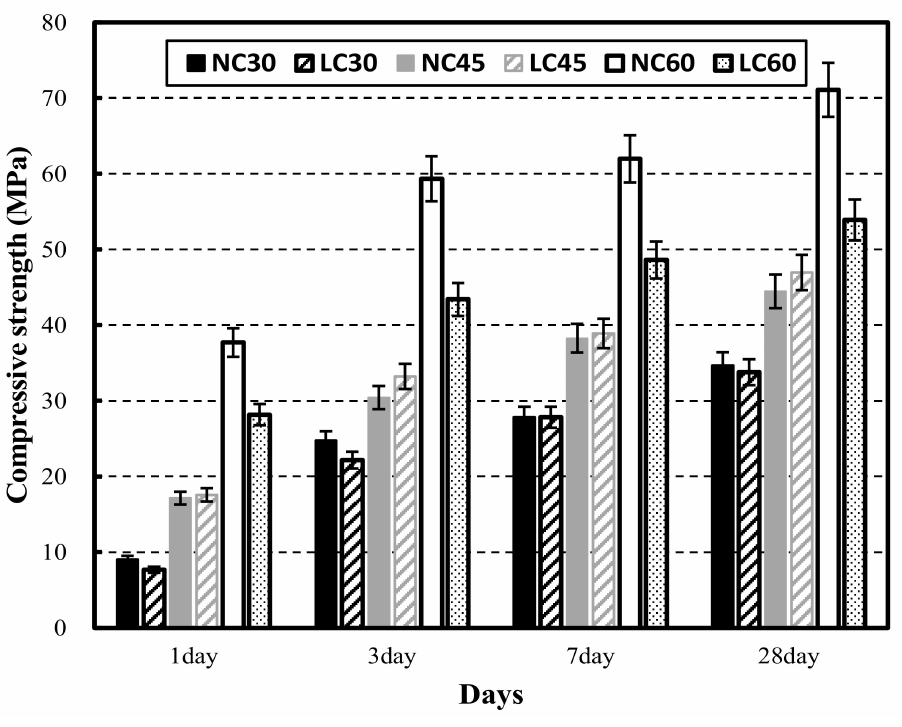
Figure 2. Compressive strength of normal aggregate concrete and lightweight aggregate concrete at different ages.